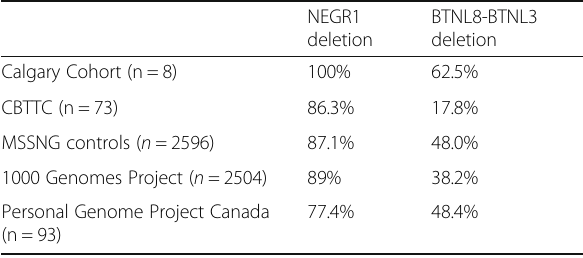
Table 1 Summary of the frequencies of NEGR1 and BTNL8- BTNL3 deletion